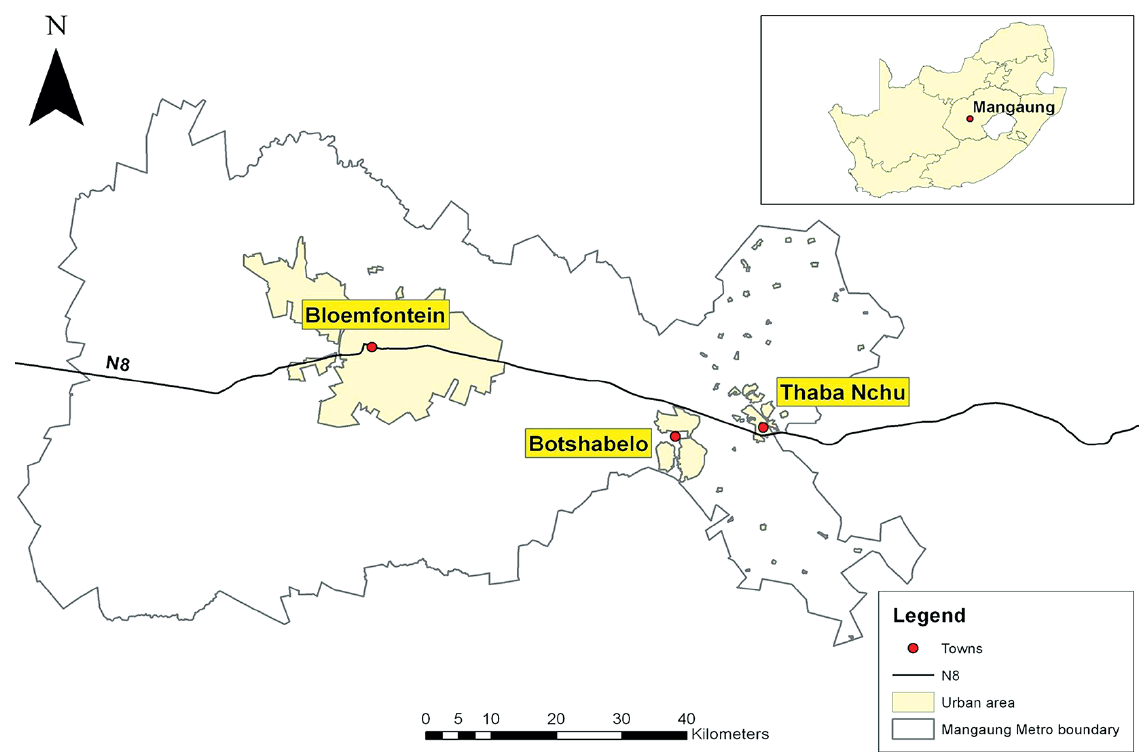
Figure 1. Mangaung’s political urban geography. Source: Marais et al. (2014). Mangaung’s intermediate size does not detract from its spatial quality as a functional urban area that undergoes socio-spatially transformative processes similar to those experienced in other cities. Its classification indicates that it is a different city that belongs to a different cate- gory or class of cities (Robinson, 2002; Rondinelli,